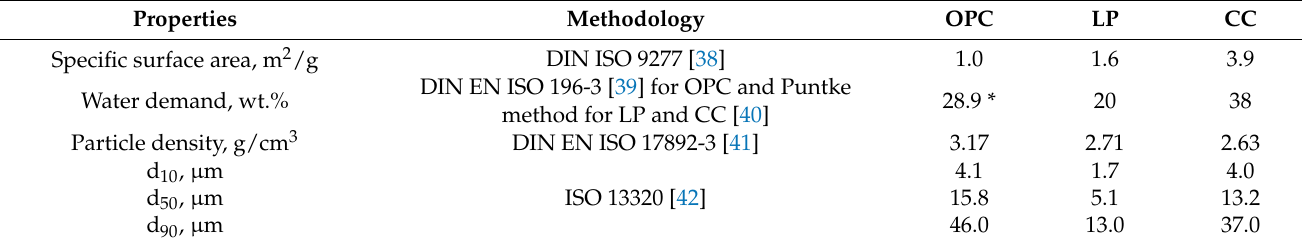
Table 2. Physical properties of OPC, LP and